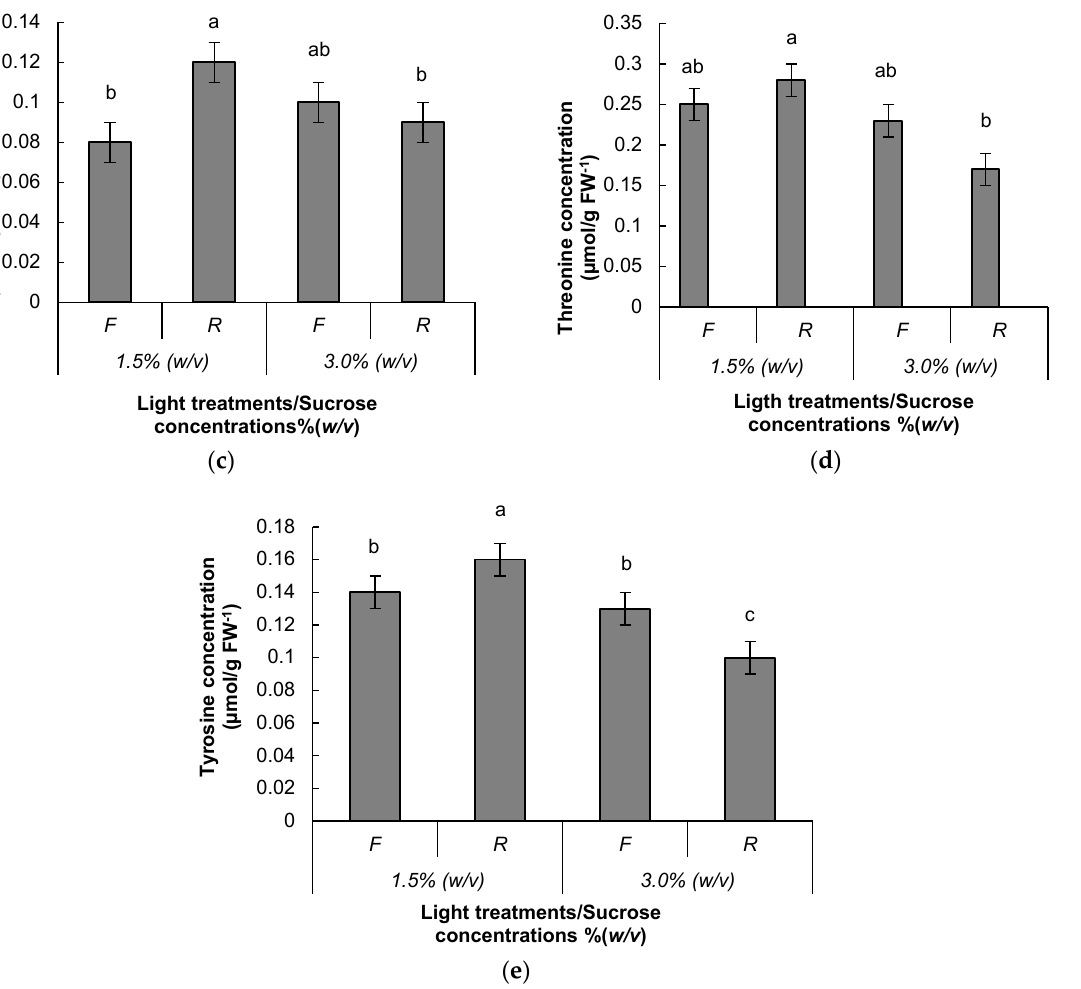
Figure 8. Effect of light treatment (white fluorescent (F) or red LEDs (R)) and sucrose concentration (1.5 and 3.0% ( w / v )) on aspartic acid ( a ), isoleucine ( b ), phenylalanine ( c ), threonine ( d ) and tyrosine ( e ) amino acid levels of Pinus radiata D. Don shoots cultured in Quoirin and Lepoivre (LP) medium [27], modified according to Aitken-Christie et al. [28], supplemented with 2 gL − 1 activated charcoal. Data are presented as mean values ± S.E. Different letters indicate significant differences by Duncan’s post hoc test ( p < 0.05).